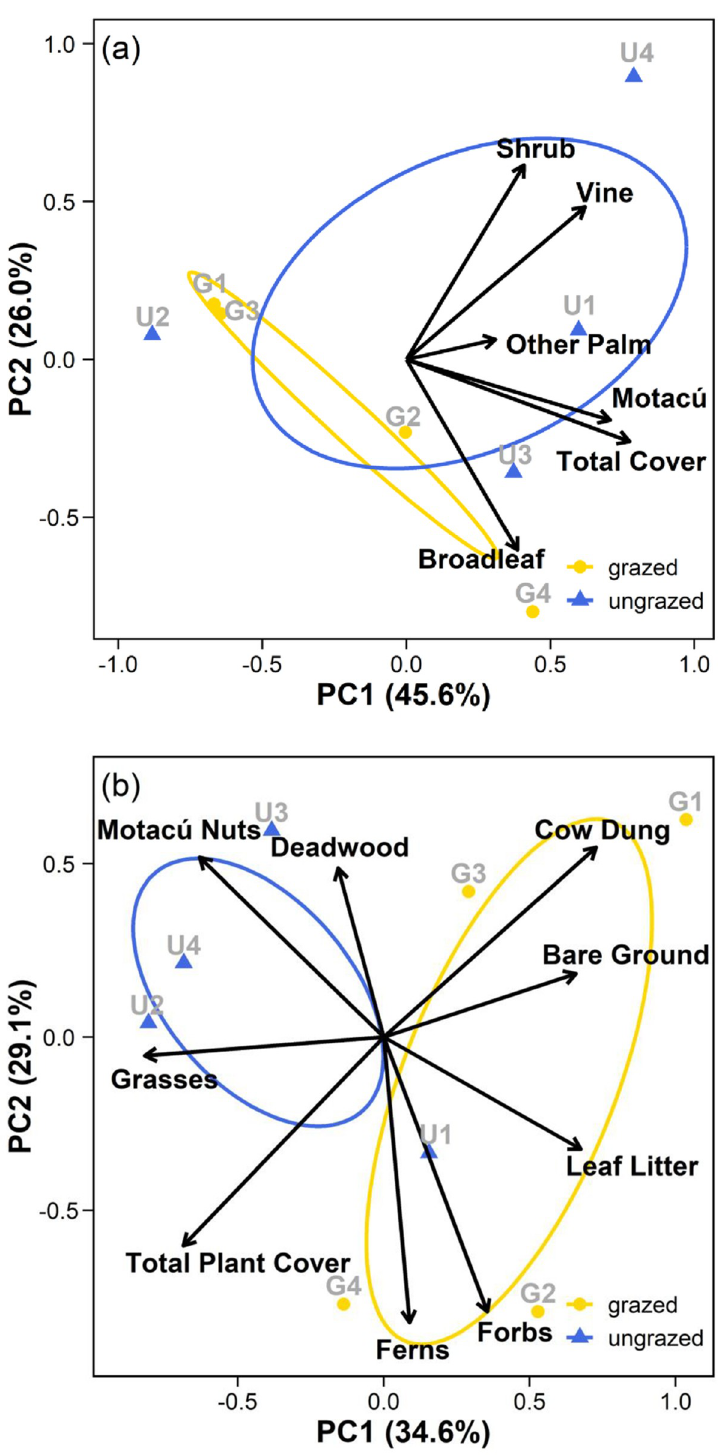
Fig 3. Principal Components Analysis (PCA), showing the first two principal components (PC1 and PC2) for a) shrub cover data and b) ground cover data in grazed and restored areas of the reserve. The variance explained by each axis is indicated on the axis label. Ellipses show standard deviation from the centroid value for each site (grazed and restored). Arrows represent the directional relationship of variables on axes. Arrow length is proportional to the relative strength of the relationship of each